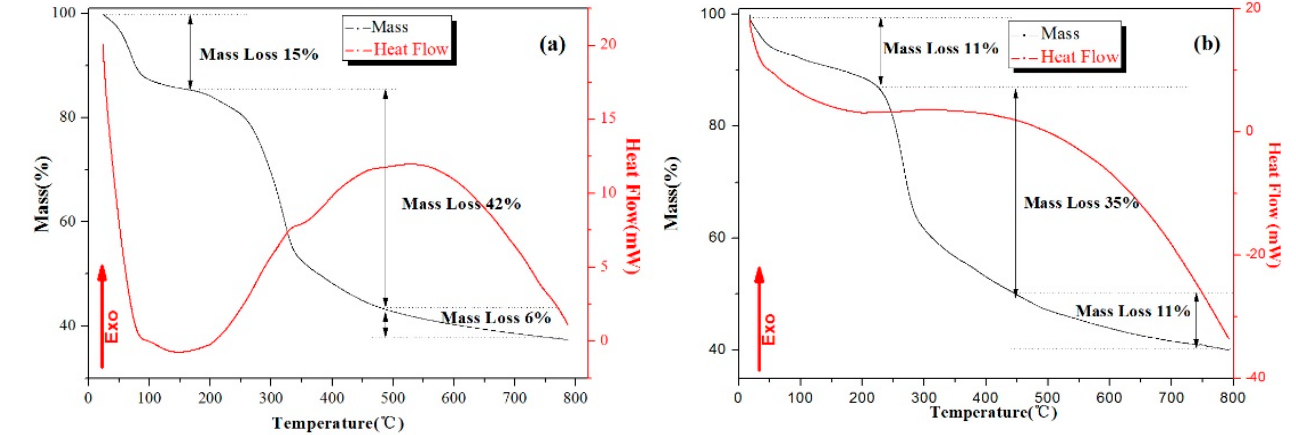
Figure 1. TG and DTA curves of the precursor for ( a ) the DIC method and ( b ) the IHC method.